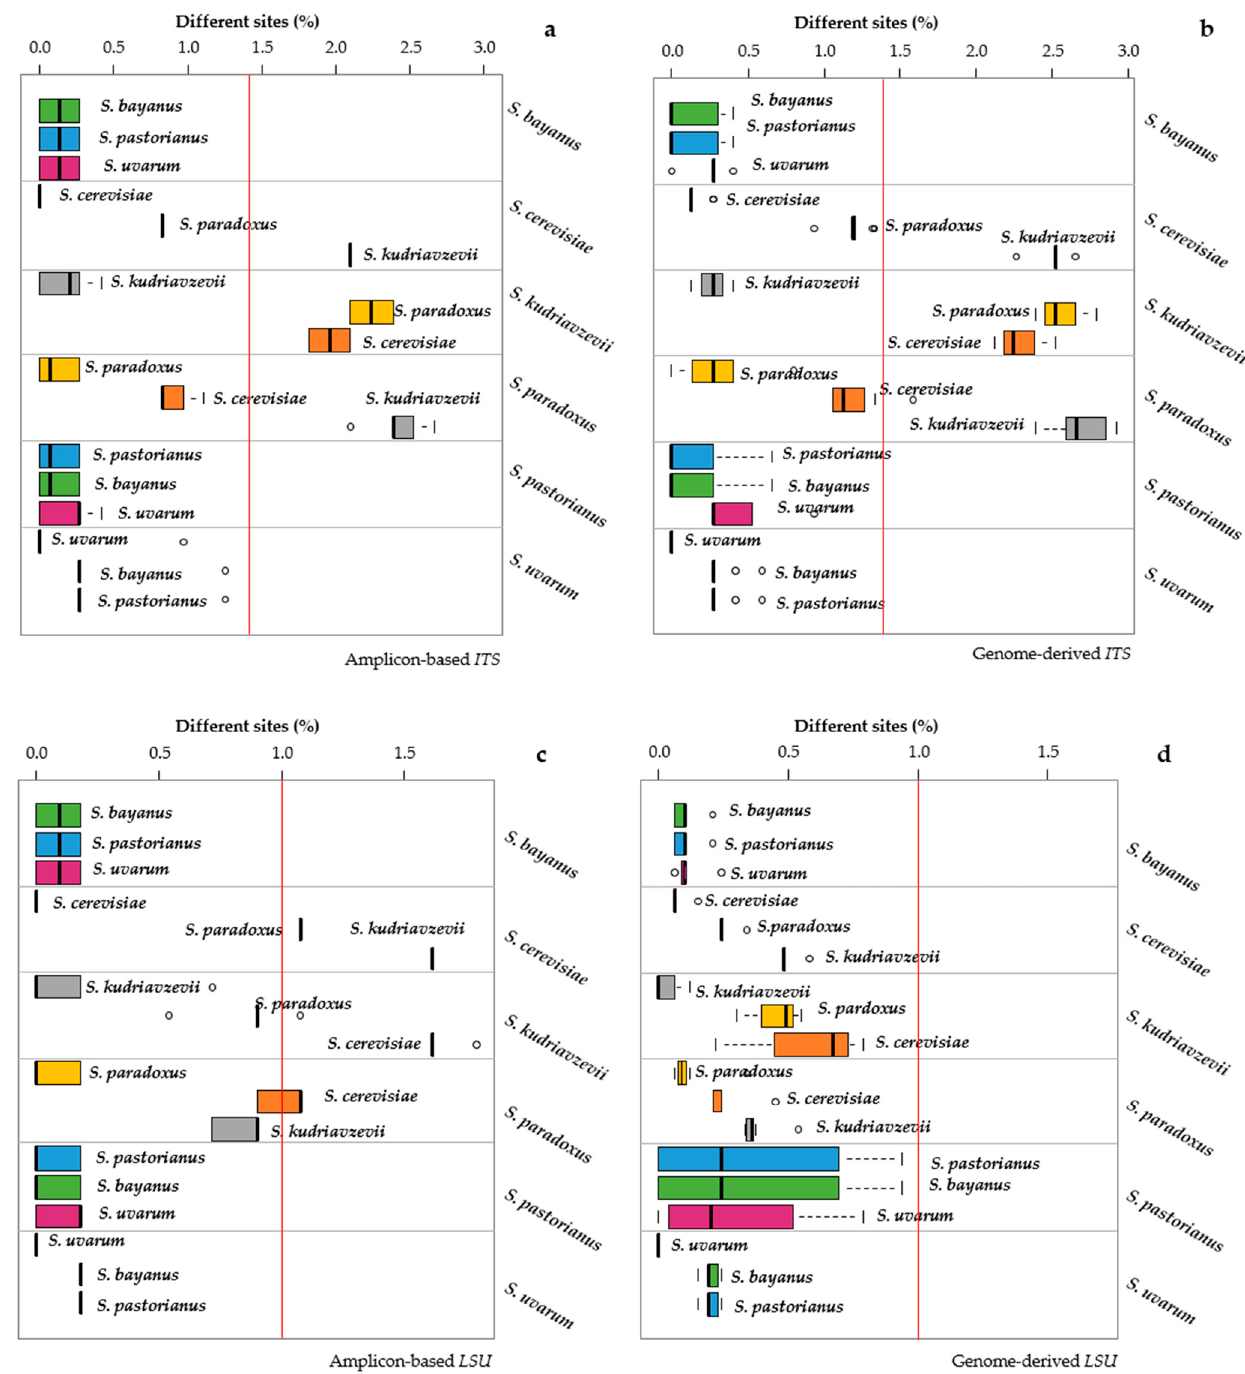
Figure 1. Distances among and within the Saccharomyces species. Distances obtained with standard and genomic Internal Transcribed Spacer ( ITS ) (expressed as % of substitution in comparison to the type strain) are displayed in panels ( a , b ), respectively. The standard and genomic distances from Large ribosomal subunit ( LSU ) markers are reported in panels ( c , d ), respectively. Each subpanel reports the distances of the strains belonging to the species under study (indicated on the right of the subpanel) with the sequences of the type strains of the three closest species (indicated close to the box). For instance, the topmost subpanel of ( a ) reports the intra- and interspecific distances of S. bayanus from the sequences of the S. bayanus , S. pastorianus and S. uvarum type strains. The width of each box represents the variability of the distances of the strains of each species from the type strains of the three closest species. The internal variability of each species is indicated by the topmost box of each subpanel. The distances among the means of the species are displayed as the distances between the vertical l, thick segments within the boxes.